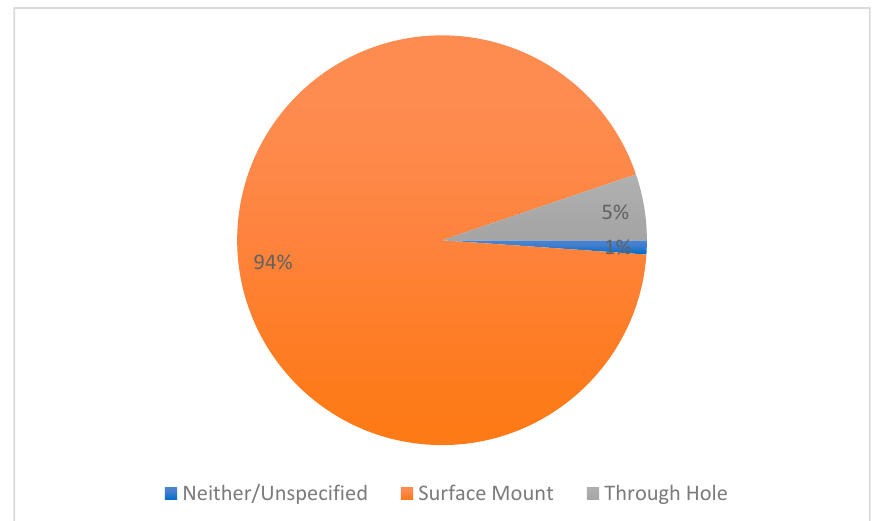
Figure 3. Quantity of surface-mount versus through-hole components.